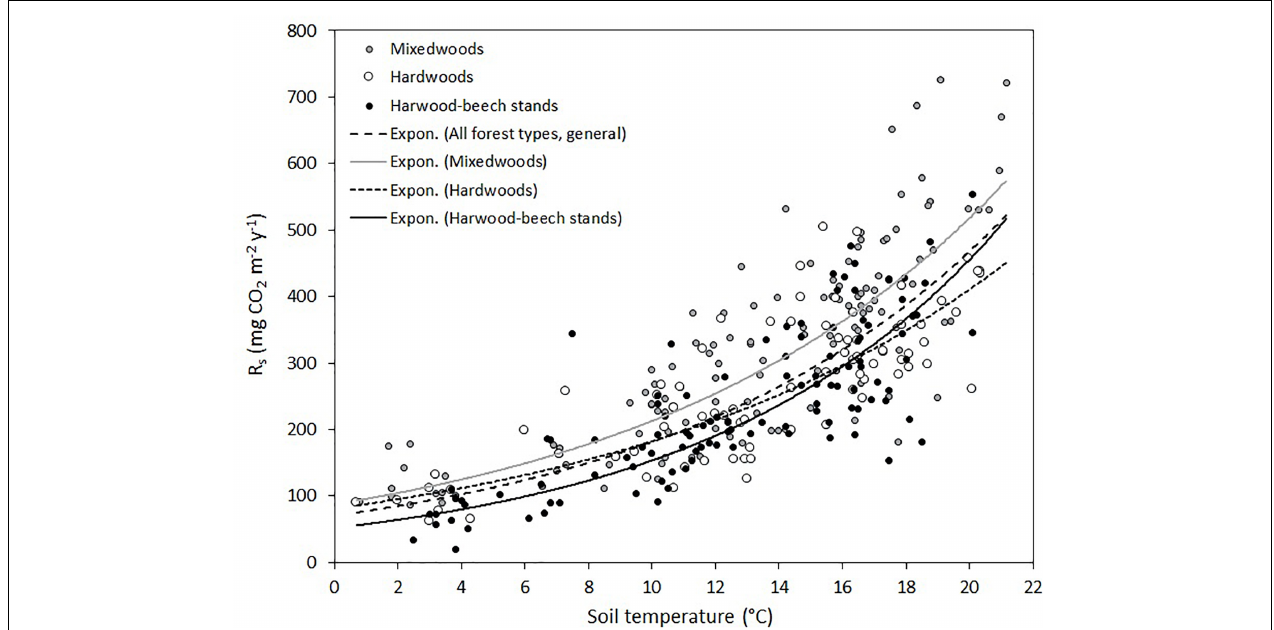
FIGURE 2 | Exponential relationships between soil temperature and soil respiration rates (R s ) for each forest type individually and for all forest types combined (general model). Parameter estimates and Q 10 of equation R s = a × e ( b × soiltemperature ) are presented in Table 3 .